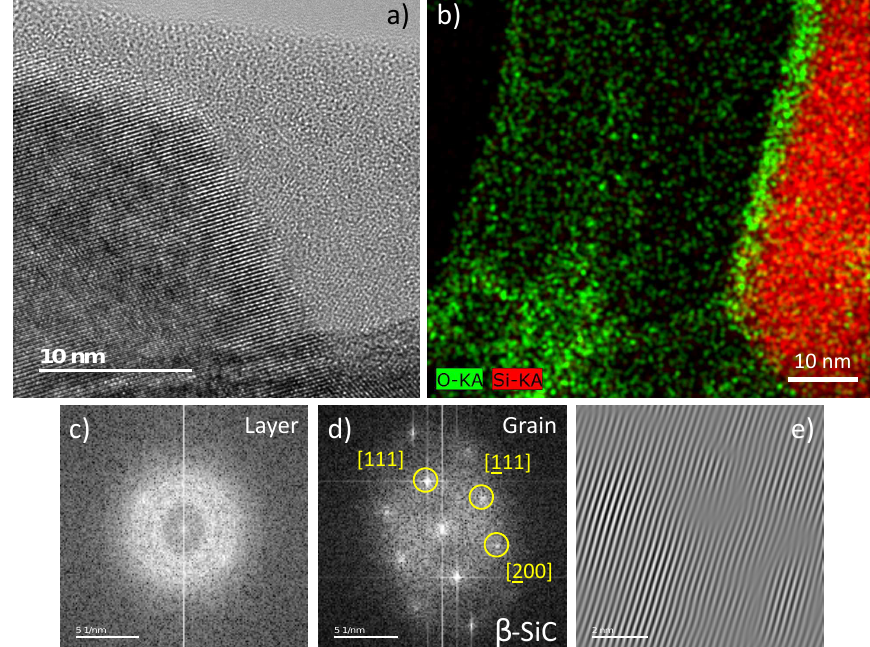
Figure 4. ( a ) High resolution transmission electron microscopy (HRTEM) view close to the surface of a silicon carbide grain showing the presence of a thin layer; ( b ) Combined EDS maps for Si and O showing that the surface layer of silicon carbide grains is enriched in oxygen; ( c ) fast Fourier transform (FFT) on the surface layer; ( d ) FFT in the core of the silicon carbide grain; ( e ) Inverse FFT using the (cid:16) (cid:17) 200 direction of the silicon carbide